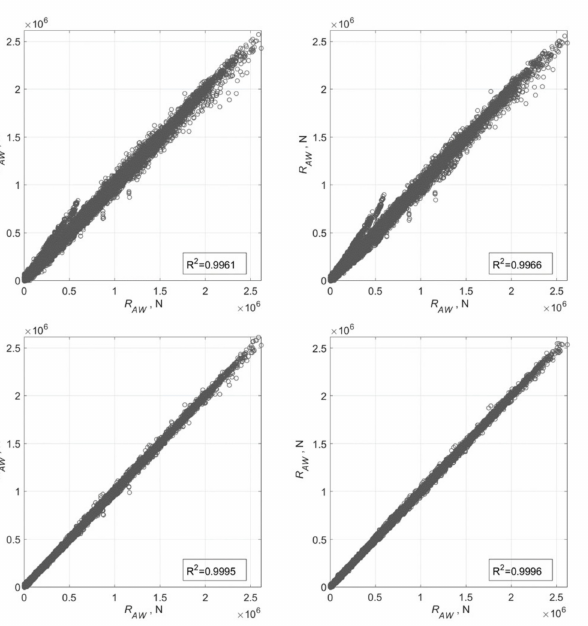
Figure 8. The regression plots for ANN with 55 neurons in the hidden layer for SGD ( upper left ), SCG ( upper right ), LM ( lower left ), and LM with BR ( lower right